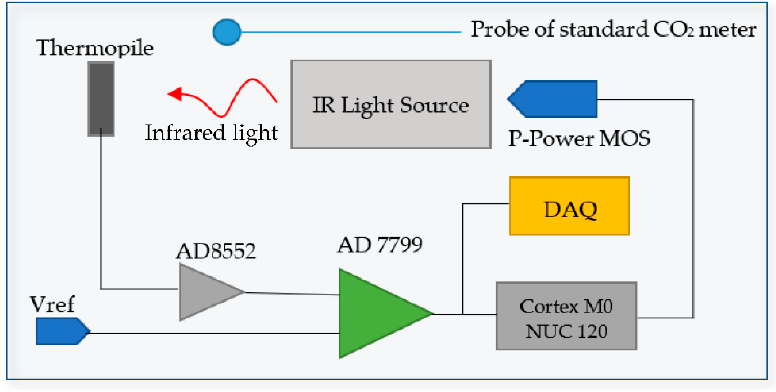
Figure 7. Experimental setup for NDIR modulation.